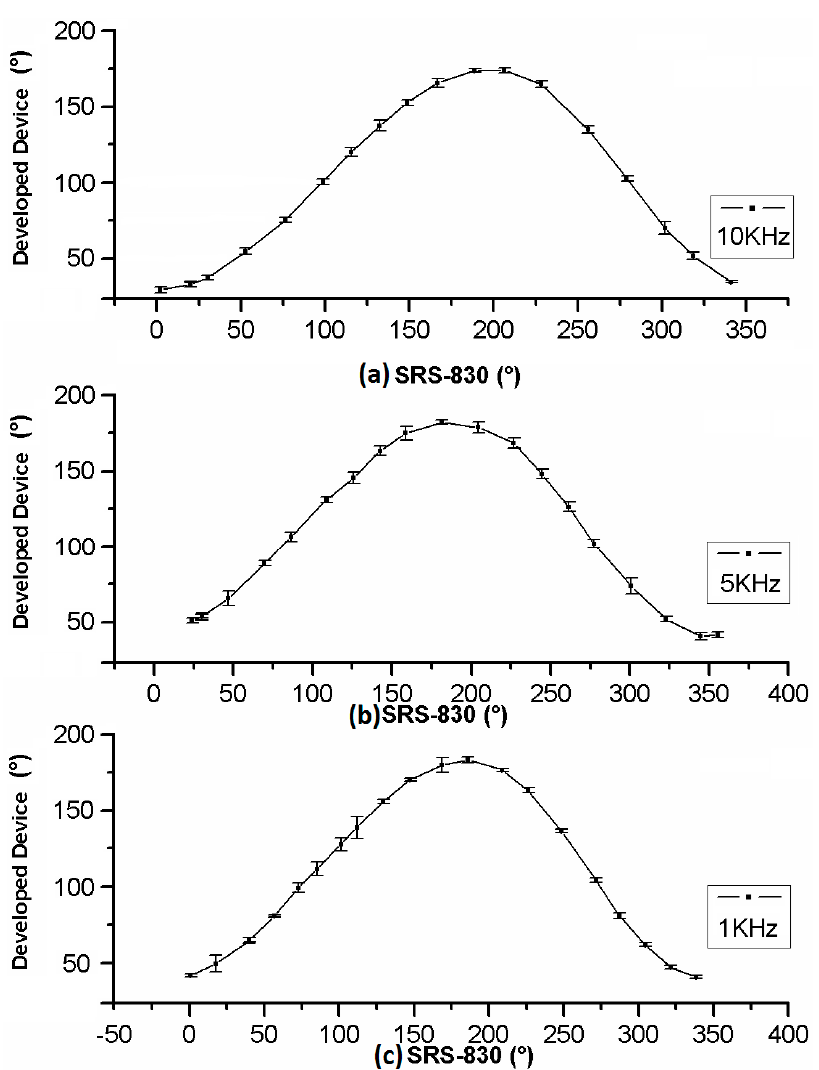
Figure 6. Phase Shift Detection response gotten by this work versus SR830 LIA at different frequencies: ( a ) 10 kHz; ( b ) 5 kHz; and ( c ) 1 kHz.